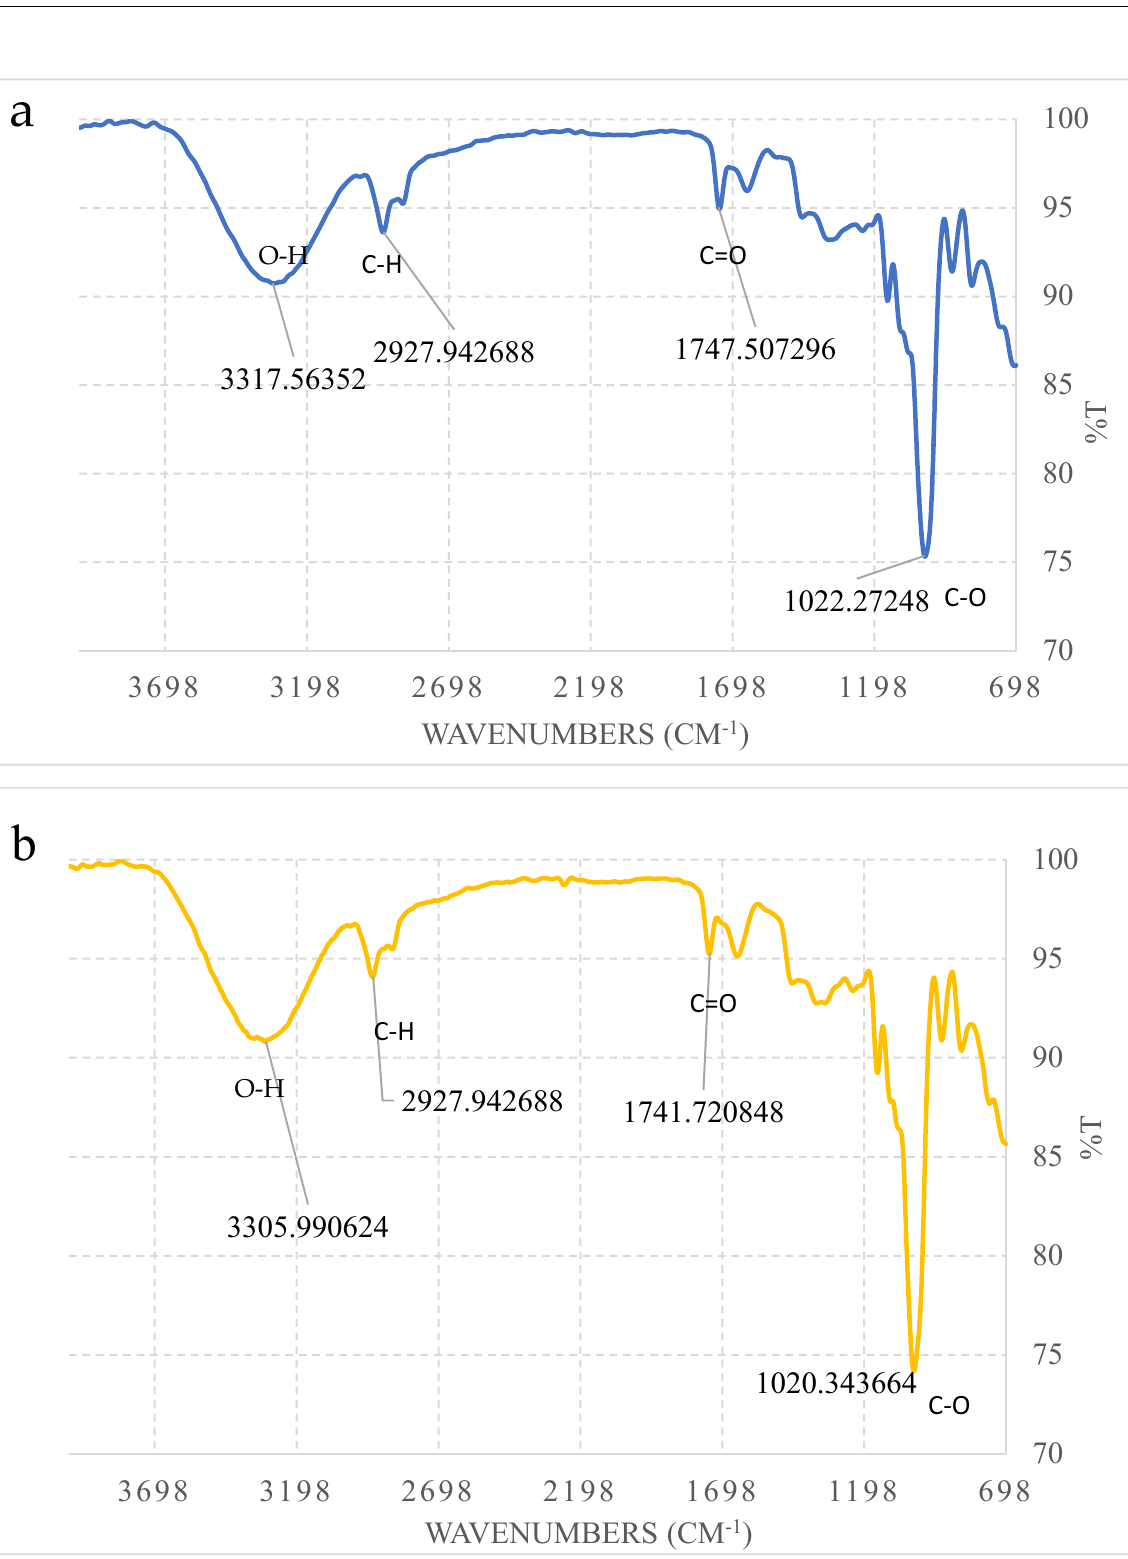
Figure 3. FTIR spectra of the prepared bioplastic samples ( a ) ginger tea and ( b ) green tea. Table 3. Band assignment of ginger tea and green tea bioplastics. Sl.